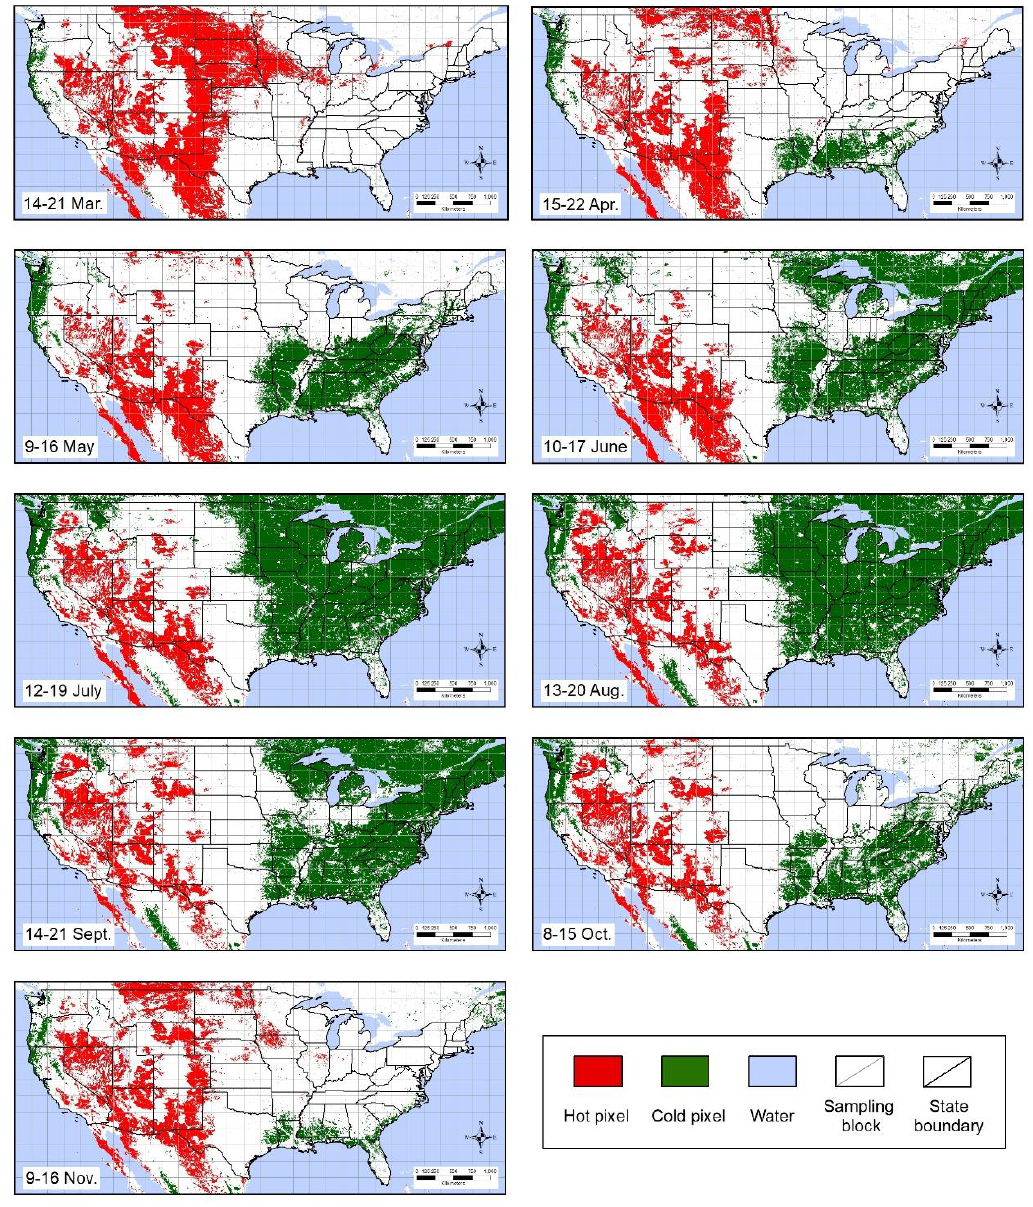
Figure 2. Maps of hot and cold pixels created based on the 10-year average (2008–2017) LST and NDVI images. The label of each map indicates the dates of the beginning and the end of the 8-day interval.